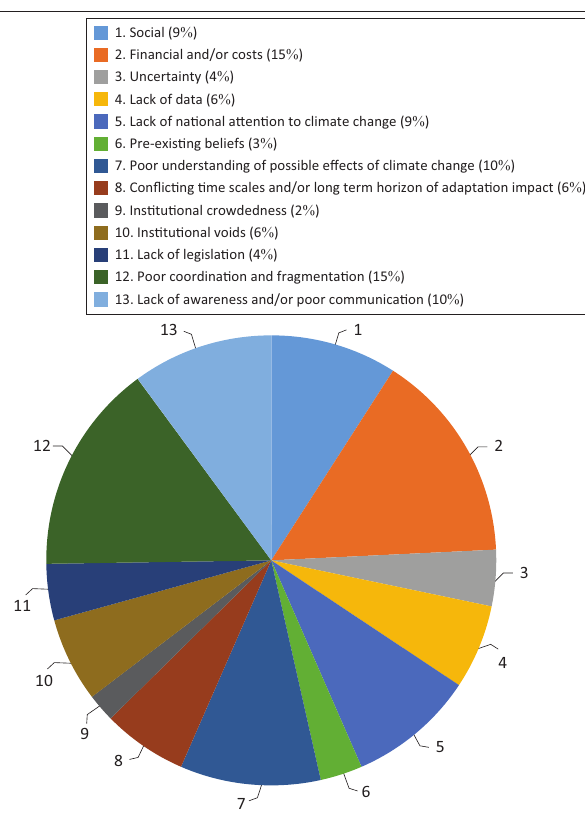
FIGURE 4 : Barriers that present most challenges to